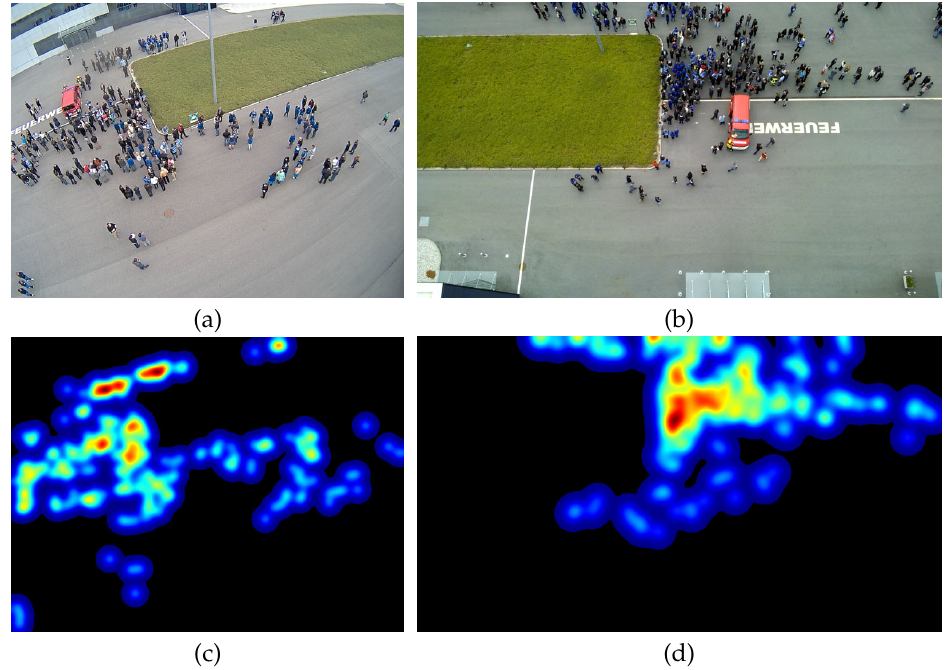
Figure 2. Both images in the top row ( a , b ) contain 254 people, however, the densities in the bottom row ( c , d ) have different spatial